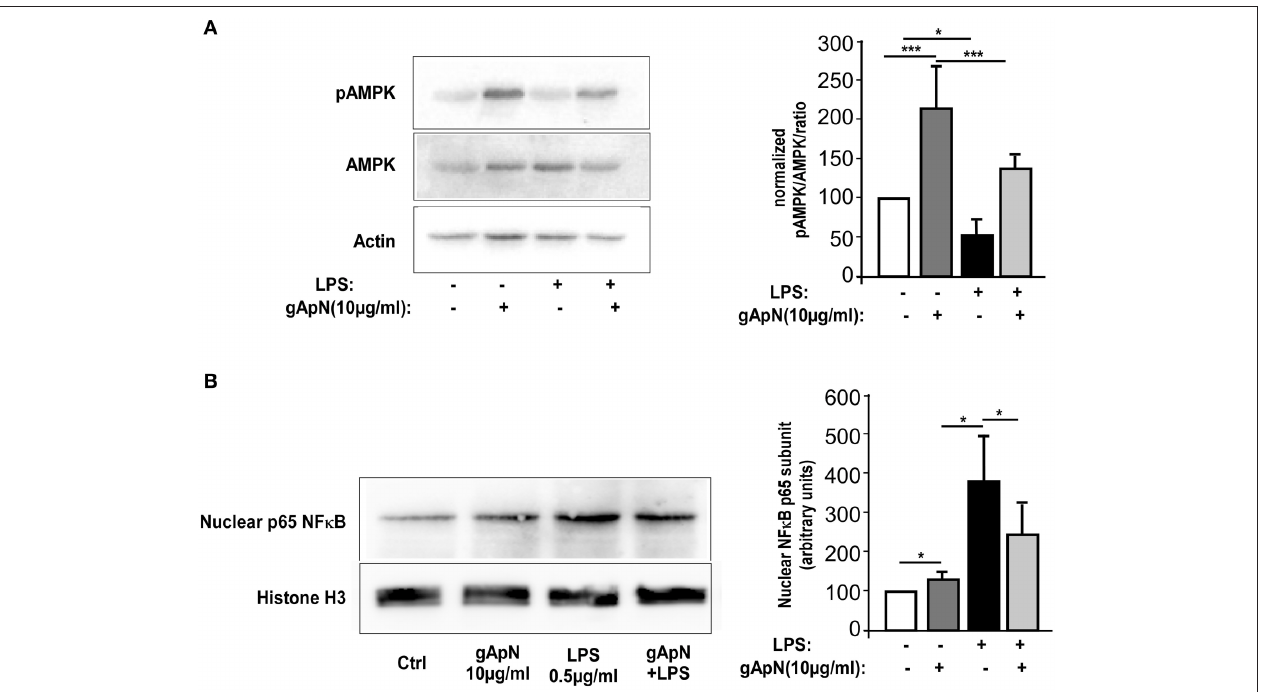
FIGURE 6 | Globular adiponectin activates AMPK phosphorylation and limits NF- κ B nuclear translocation. (A) Representative western-blot analysis (left panels) of AMPK phosphorylation at Thr172 (pAMPK) in BV2 cells. Right panel shows quantification by densitometry of pAMPK/AMPK ratio of western-blots from 3 independent experiments. Actin immunoreactivity was used for normalization. Mann & Whitney for comparison between groups, * p < 0.05, *** p < 0.005. (B) Nuclear fractions were obtained from BV2 cells as described in the Materials and Methods section. Left panels show a representative western-blot of the p65 subunit of NF- κ B and Histone H3 as a nuclear marker. Right panel shows quantification by densitometry of nuclear p65 immunoreactivity of western-blots from 3 independent experiments. Histone H3 immunoreactivity was used for normalization. Mann & Whitney for comparison between groups, * p <